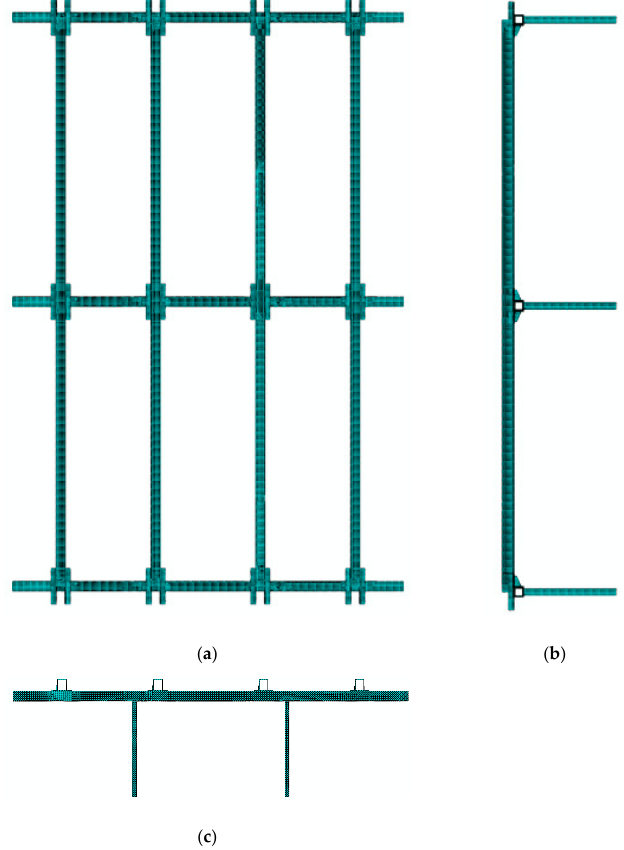
Figure 6. View of the guide-to-bunton connections model: ( a ) joint at mid-point of guide; ( b ) joint at the end of the guide.